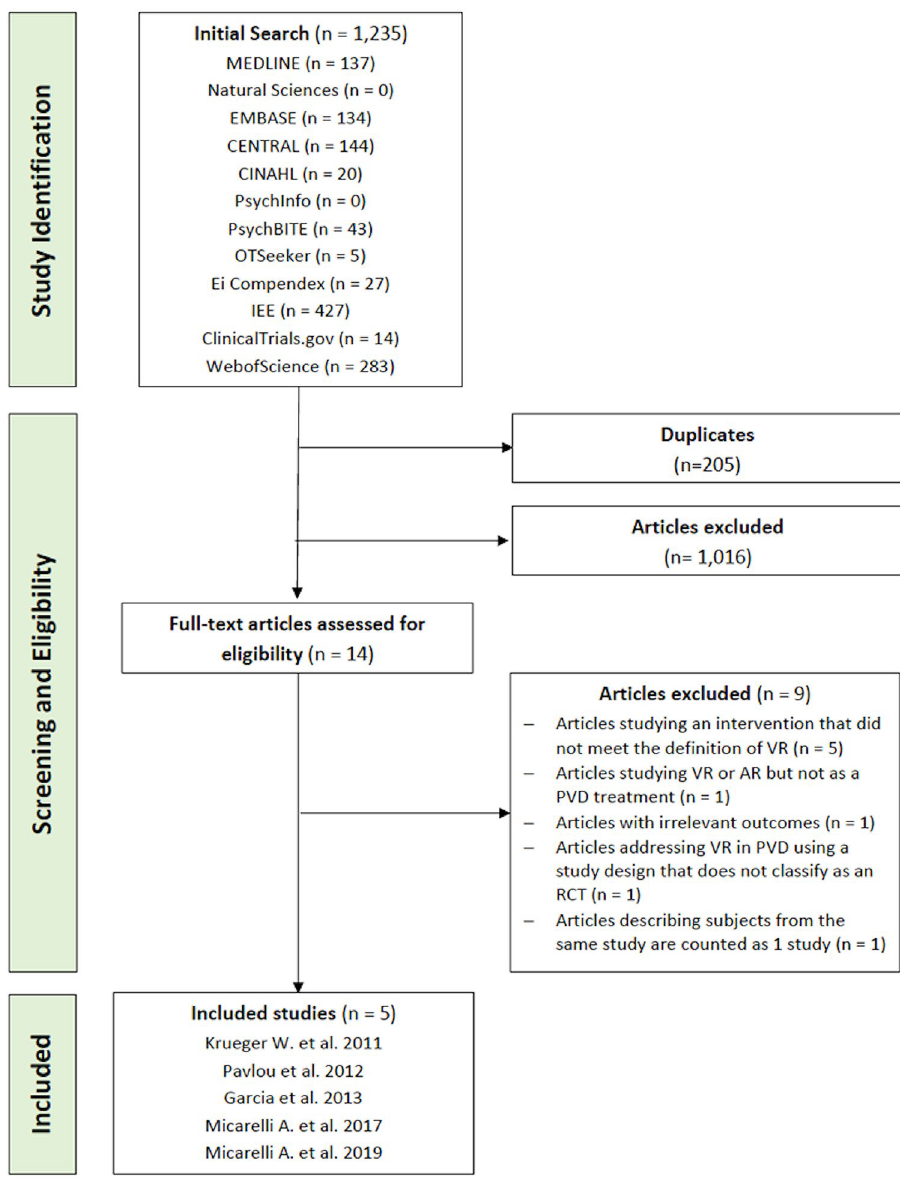
Figure 1. Flow of the article screening process for this systematic review. Flow chart was generated using Microsoft